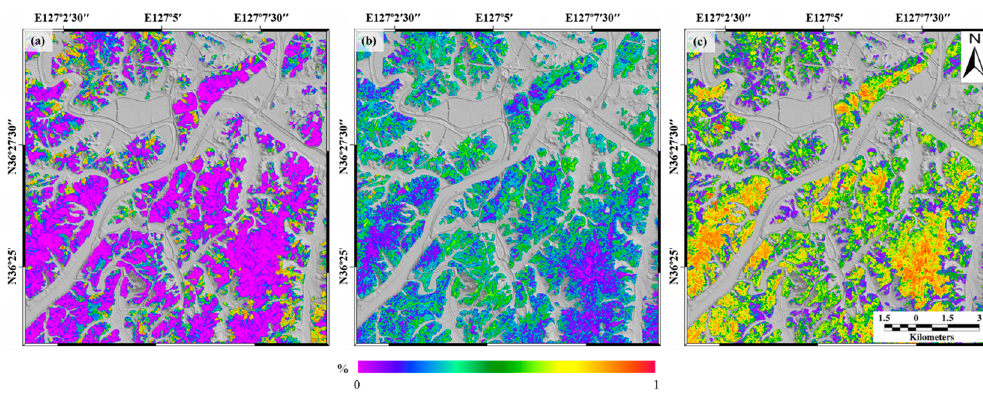
Figure 11. Probability maps of forest vertical structure using ANN approach: ( a ) single-layer, ( b ) double-layer, and and ( c ) triple-layer.